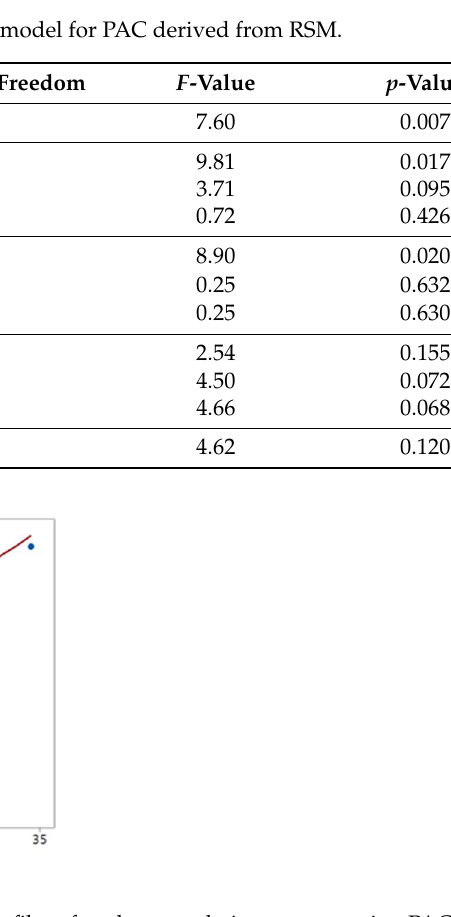
Figure 3. The actual and predicted [PO 4 -P] profiles after the coagulation process using PAC.